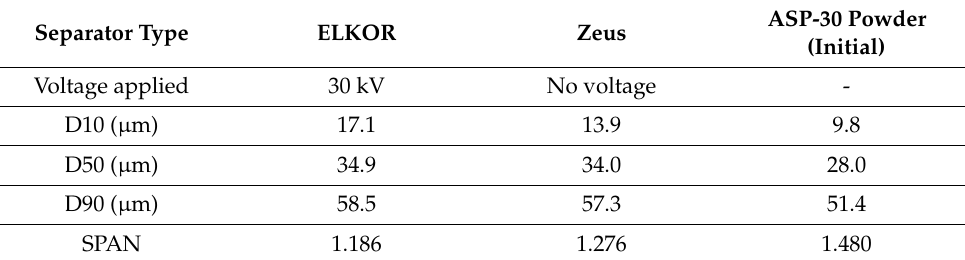
Table 4. Comparison of the initial ASP-30 powder characteristics with the best results of size distribution after using ELKOR and Zeus